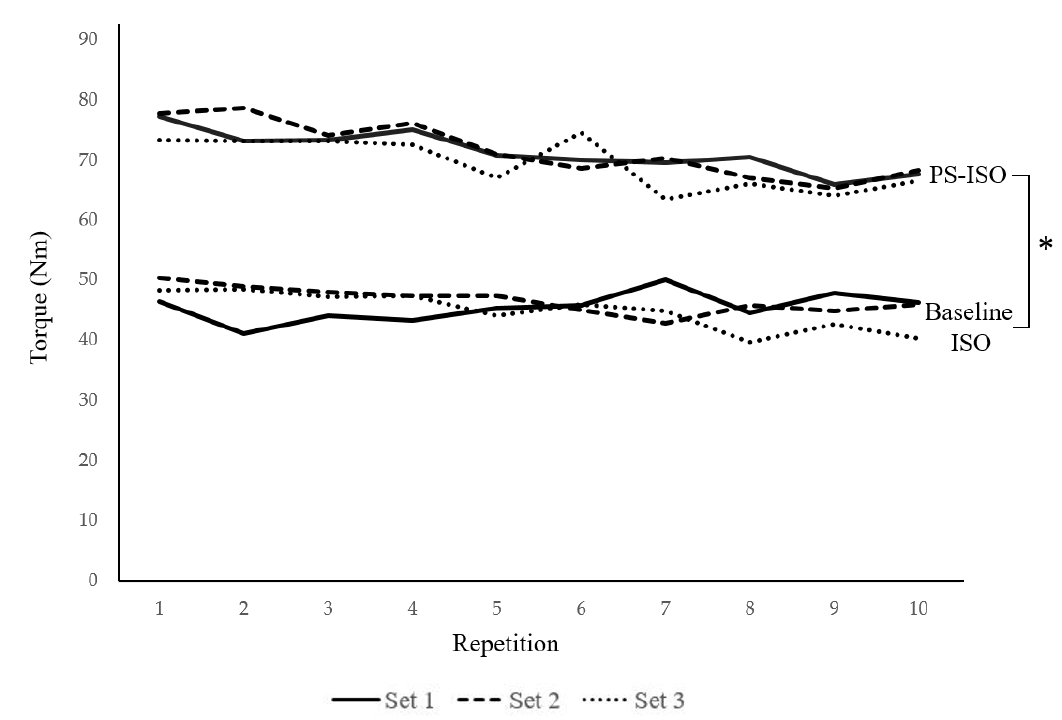
Figure 2. Mean baseline isometric and PS-ISO torque during 10 consecutive repetitions over three sets. * indicates a significant increase in mean torque from baseline isometric contractions to PS-ISO contractions across all repetitions and all sets ( p ≤ 0.001).